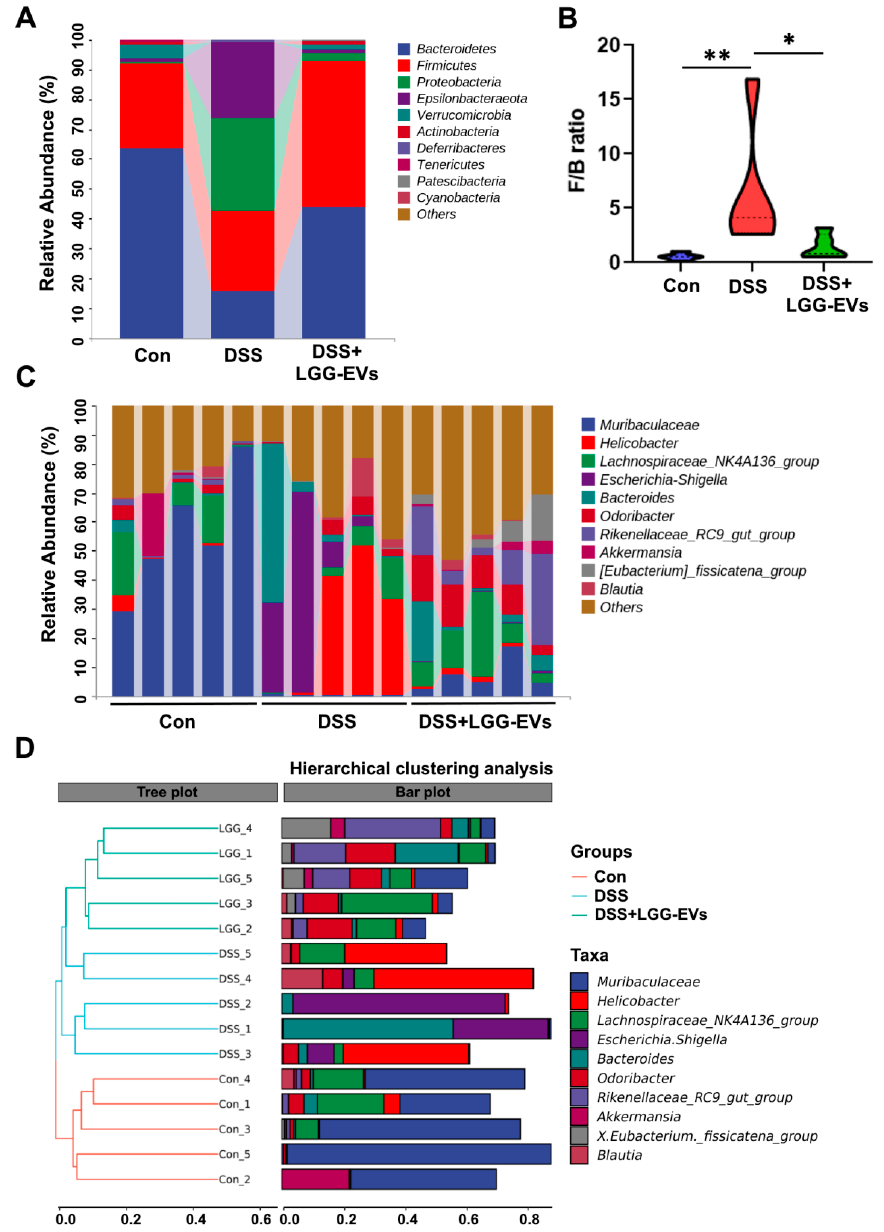
Figure 4. LGG-EVs reshaped the structure of gut microbiota in colitis mice. ( A ) Bar plots of the taxonomic composition at the phylum level. ( B ) The ratio of Firmicutes to Bacteroidetes in different groups. * p < 0.05, ** p < 0.01. ( C ) Bar plots of the taxonomic composition at the genus level. ( D ) Hierarchical clustering analysis based on unweighted UniFrac